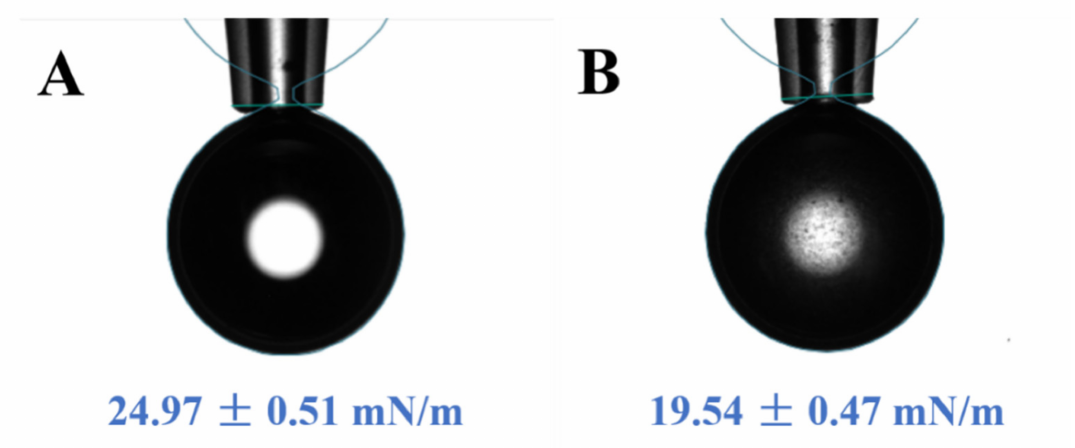
Figure 2. The effect of sorghum flour on the interfacial tension between MCT and water ( A : control; B : sorghum flour).